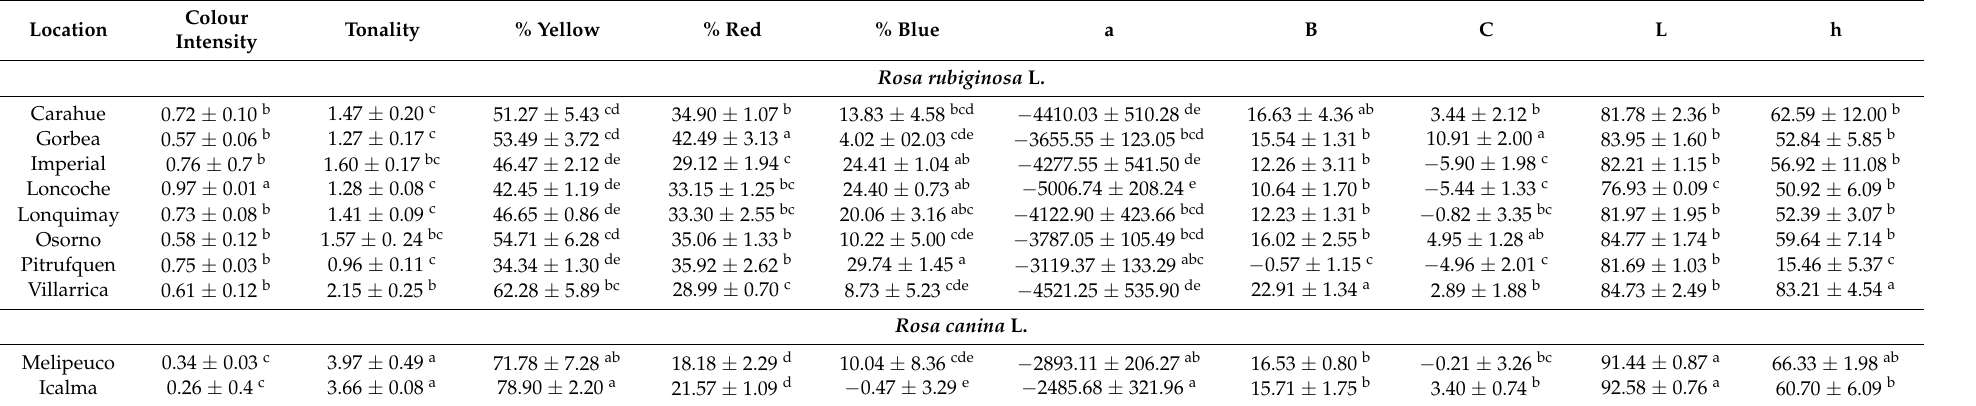
Table 3. Colour parameters including colour intensity, hue, yellow, red, blue, a, b, L, C and h, by CieLAB method in fruit of rosehip from different locations. Different letters in each sub-figure indicate the presence of statistically significant differences according to the Tukey’s multiple range test ( p ≤ 0.05; n =